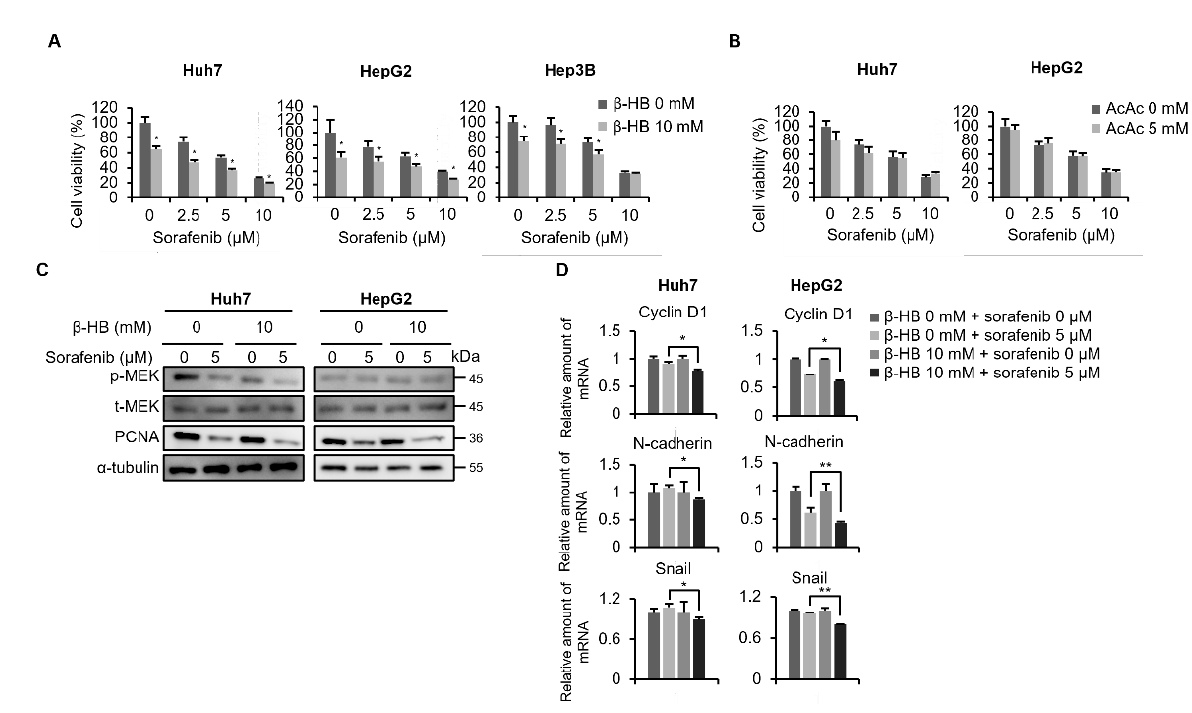
Figure 5. β -Hydroxybutyrate ( β -HB) pretreatment decreased cell proliferative ability and enhanced the sorafenib sensitivity in hepatocellular carcinoma (HCC) cells. ( A , B ) Huh7, Hep3B, and HepG2 cells were maintained in β -HB- or AcAc-supplemented medium for 2 days, and afterwards cells were seeded in 96-well plates and treated with 0, 2.5, 5, and 10 µ M sorafenib for 48 h. An MTT assay was conducted to detect cell viability. ( C ) Huh7 and HepG2 cells were treated with sorafenib (0 or 5 µ M) combined with β -HB (0 or 10 mM) for 48 h, phosphorylated (p)-, total (t)-MEK and proliferating cell nuclear antigen (PCNA) were evaluated by Western blotting. α -Tubulin was used as an internal control. ( D ) mRNA expressions of Cyclin D1, N-cadherin, and Snail in sorafenib combined with β -HB treated Huh7 and HepG2 cells were analyzed by QPCR. * p < 0.05; ** p < 0.01 vs. the β -HB or AcAc free control. Data are shown as the mean ± SD. The representative data are obtained from two independent